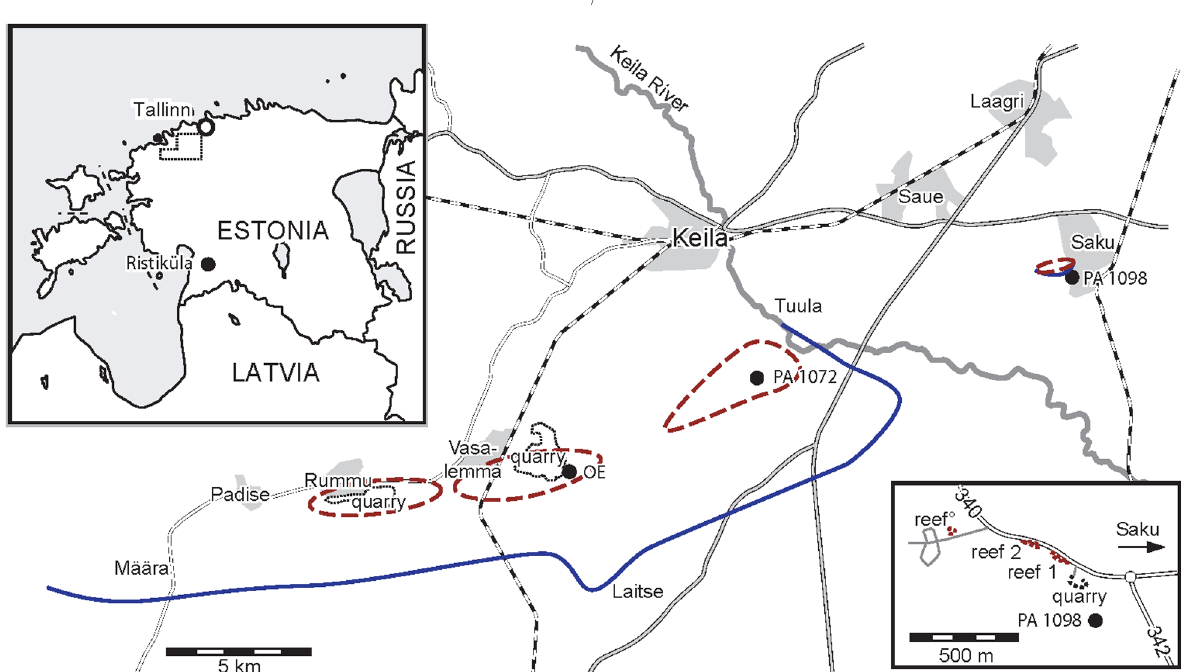
Fig. 1. Regional distribution of the Vasalemma Formation, Late Ordovician (solid black line), with areas of reef occurrences (dashed line). Based on Kr(cid:246)ger et al.